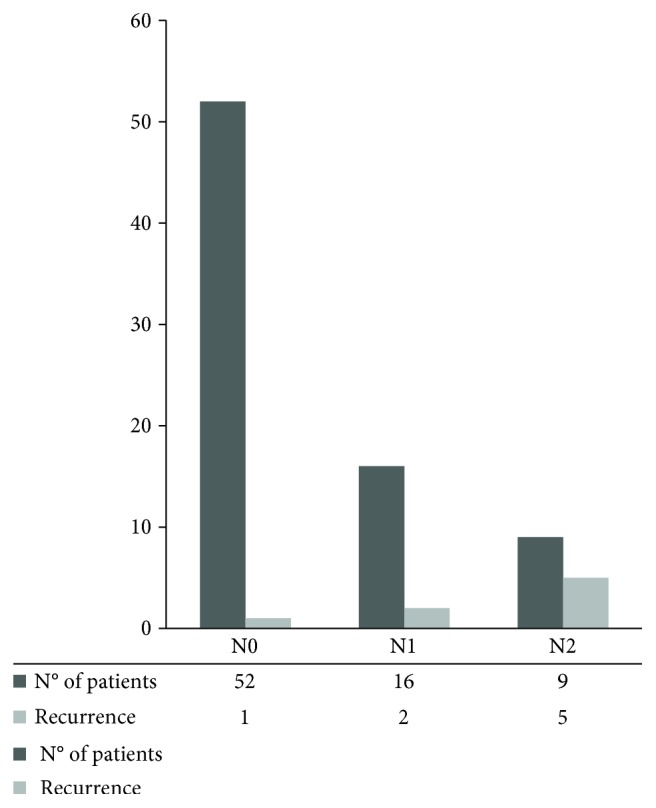
Disease recurrences between N groups.